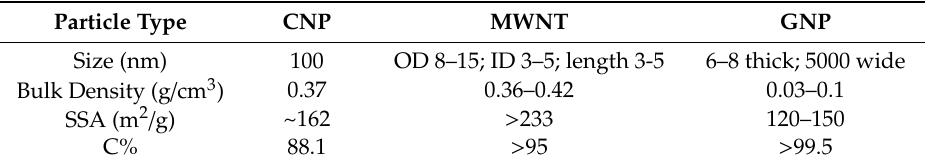
Table 1. Physical properties of carbon nanoparticles (SSA: specific surface area; OD: outer diameter; ID: inner